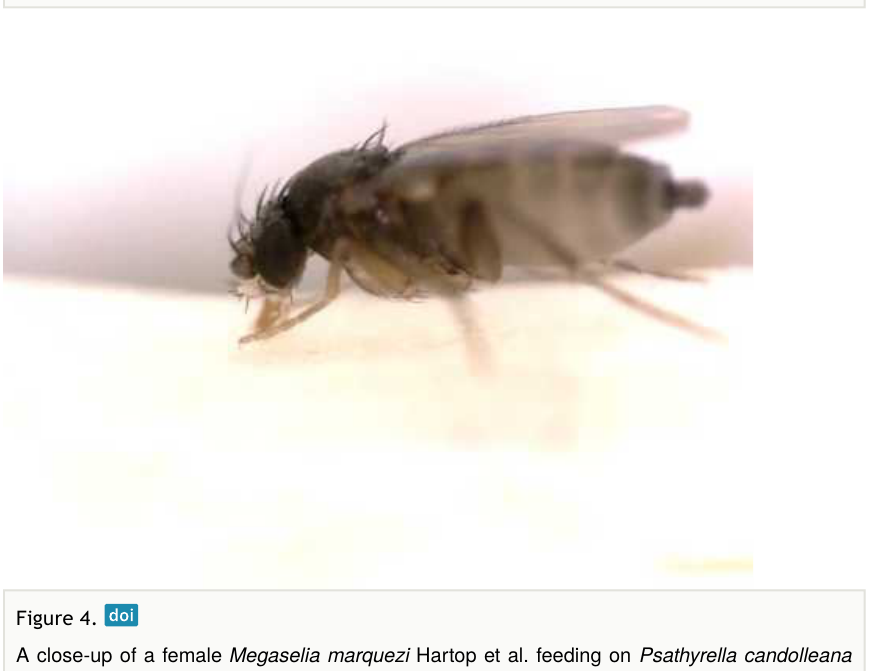
Figure 3. A female Megaselia marquezi Hartop et al. feeding on Psathyrella candolleana (Fr.) Maire. A single larva can be seen feeding in the tissue beneath her.